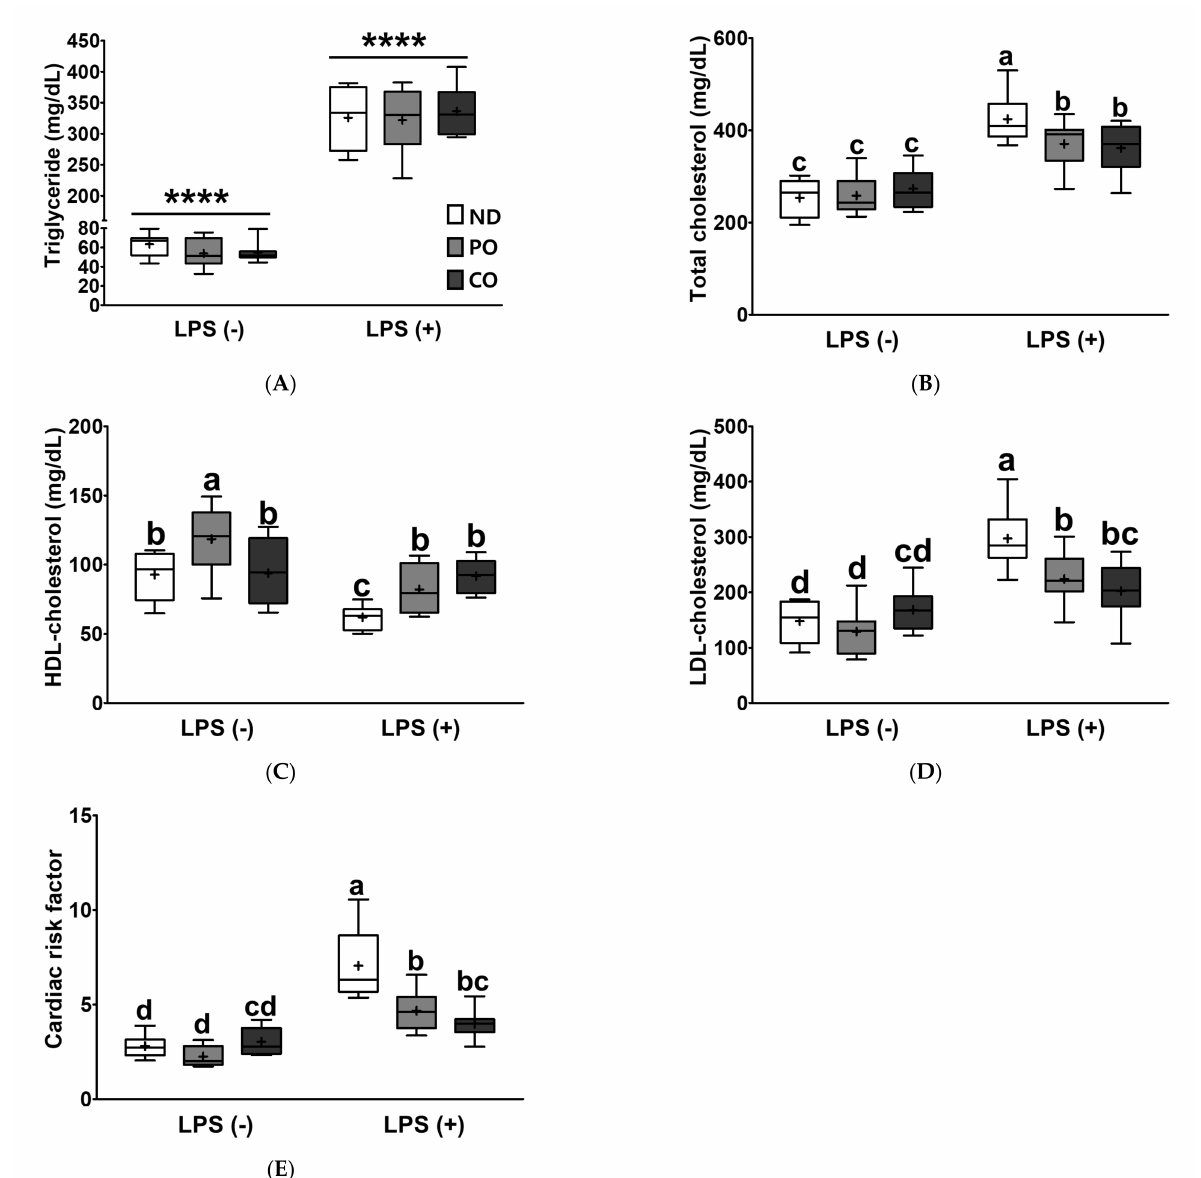
Figure 4. Partial replacement of dietary fat with PO or CO and LPS challenge on serum lipid profiles in ob/ob mice. Mice were fed either an ND or an ND partially replaced with PO or CO for 12 weeks and then treated with PBS or LPS (1 mg/kg) for 24 h ( n = 8 per group). ( A ) Triglyceride levels; ( B ) total cholesterol levels; ( C ) high density lipoprotein (HDL)-cholesterol levels; ( D ) low density lipoprotein (LDL)-cholesterol levels; ( E ) cardiac risk factor (CRF). Values are presented as box and whisker plots representing 8 mice per group. Data were analyzed using two-way ANOVA followed by Tukey’s post hoc test (LPS × Diet interaction). Asterisk indicates a significant main effect for LPS (**** p < 0.0001). Labeled means without a common letter differ ( p <